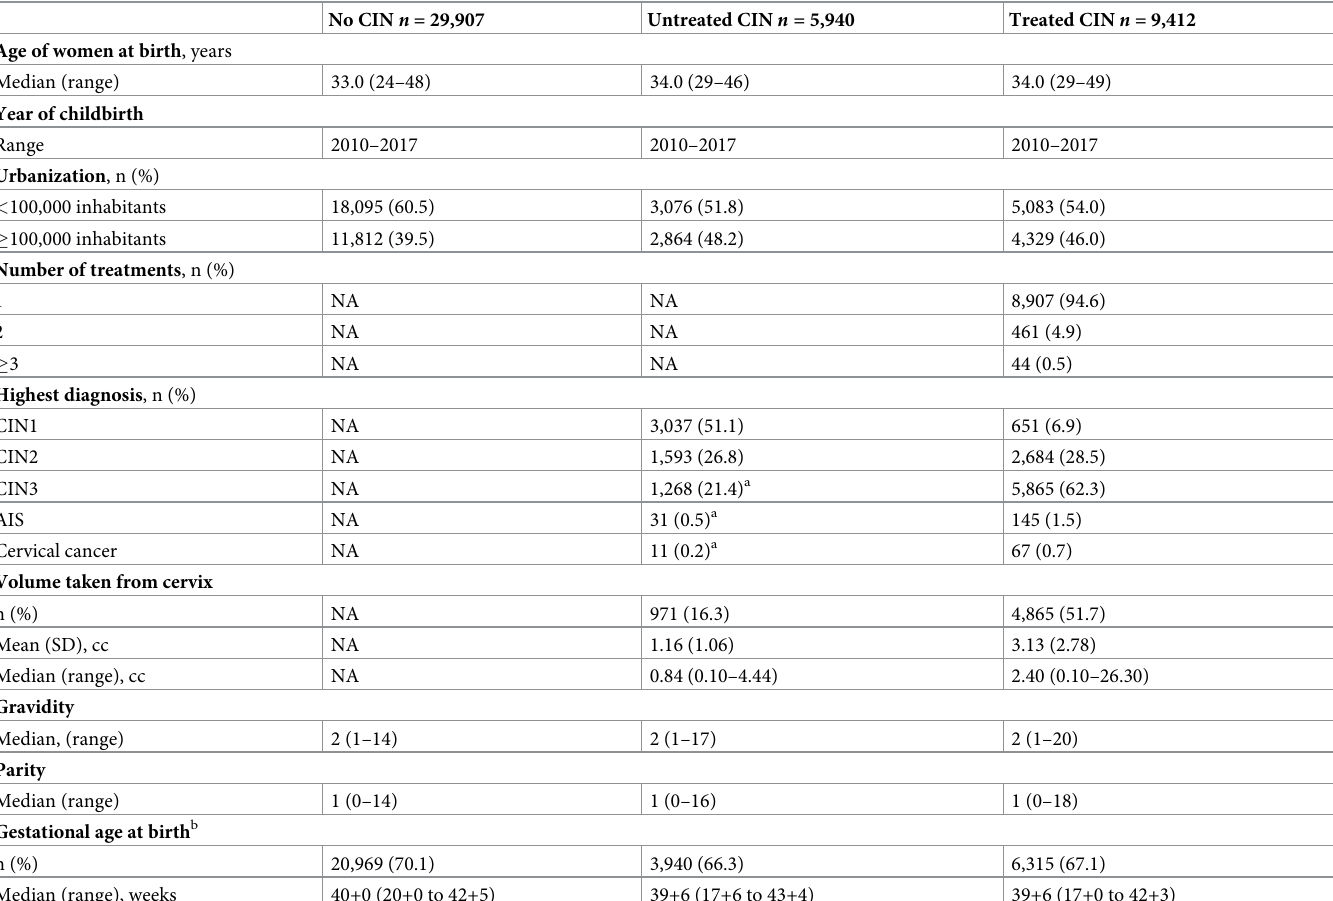
Table 1. Basic characteristics of women with no CIN, untreated CIN, and treated CIN before each